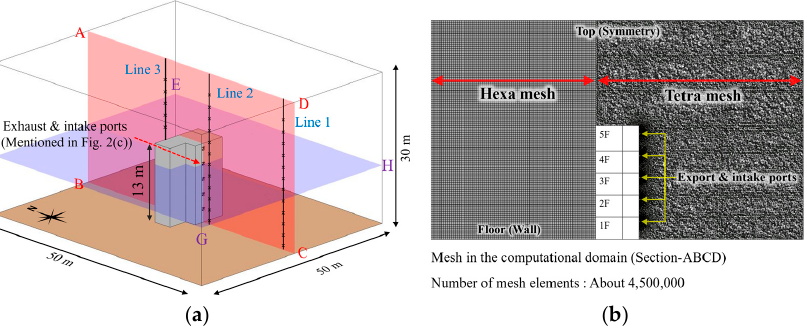
Figure 3. The geometry and mesh of target space for CFD analysis: ( a ) geometry; ( b ) mesh.